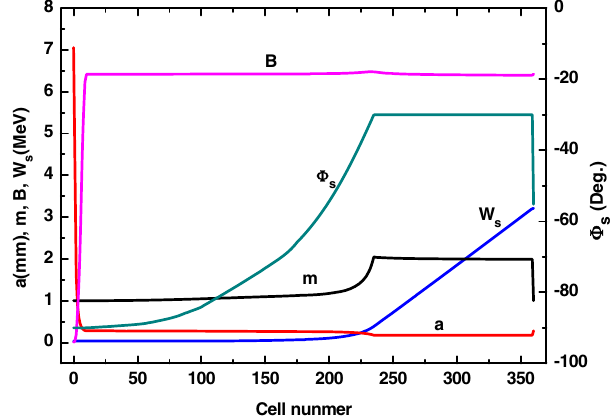
FIG. 7. Main parameter variation with cell number, where a stands for the minimum bore radius, m modulation factor, B focusingfactor, W synchronous energy,and (cid:1)